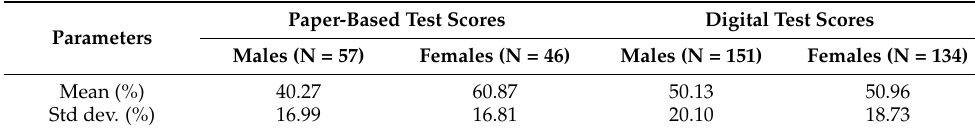
Table 4. Performance of boys and girls on paper and digital tests of the “produce” domain of visual communication.